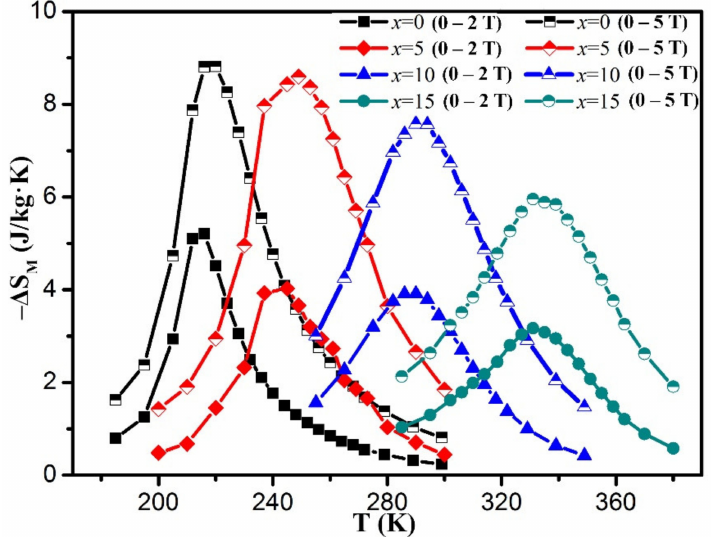
Figure 6. Magnetic entropy change ( − ∆ S M ) as function of temperature for the LaFe 11.6 Si 1.4 / x wt.%Ce 2 Co 7 ( x = 0, 5, 10 and 15) composites sintered at 1373 K for 6 h. The binder-free sintered composites show higher T C (212 K) than that of the annealed LaFe 11.6 Si 1.4 flakes (196 K). The sintering temperature is close to the optimum formation temperature of the 1:13 phase [55], which may bring about 1:13 phase formation and de- crease the α -Fe phase content (Table 1), resulting in the formation of a nonstoichiometric Fe deficient 1:13 phase (Table 2). This Fe-deficient 1:13 phase has elevated T C (Table 2), which weakens the first order magnetic transition (FOMT) and lowers the ( − ∆ S M ) max [7,18,34]. The binder-free composites exhibited the maximum magnetic entropy change ( − ∆ S M ) max of 5.2 and 8.8 J/kg · K under applied field changes of 0–2 and 0–5 T, respectively (Table